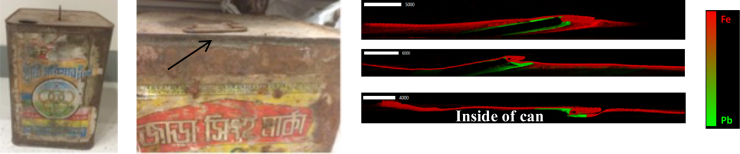
(Left) An image of one of the lead-soldered cans that previously held cooking oil; (middle) lead solder visible as designated by the arrow; (right) representative images of three can seams taken at Stanford's linear accelerator SLAC showing a cross-section of a can with lead solder (green) at seams facing the inside of the can and iron composing the can's walls (red). The elemental contribution of Pb and Fe in the cans was visualized through X-ray absorption at the respective elemental absorption edges of Pb L(III)-edge at 13035 eV and Fe K-edge 7112 eV. Normalization and dead time correction was done using the software Microanalysis Toolkit SMAK.